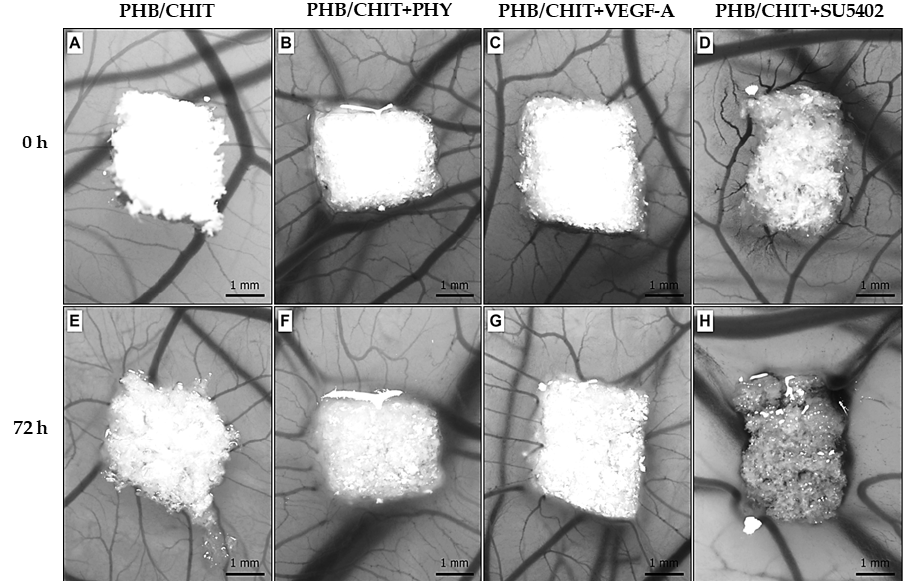
replicates: 2 images per each biological replicate, one after the implantation and one 72 h after biological replicate, one after the implantation and one 72 h after implantation). * p < 0.0001. implantation). * p < 0.0001.